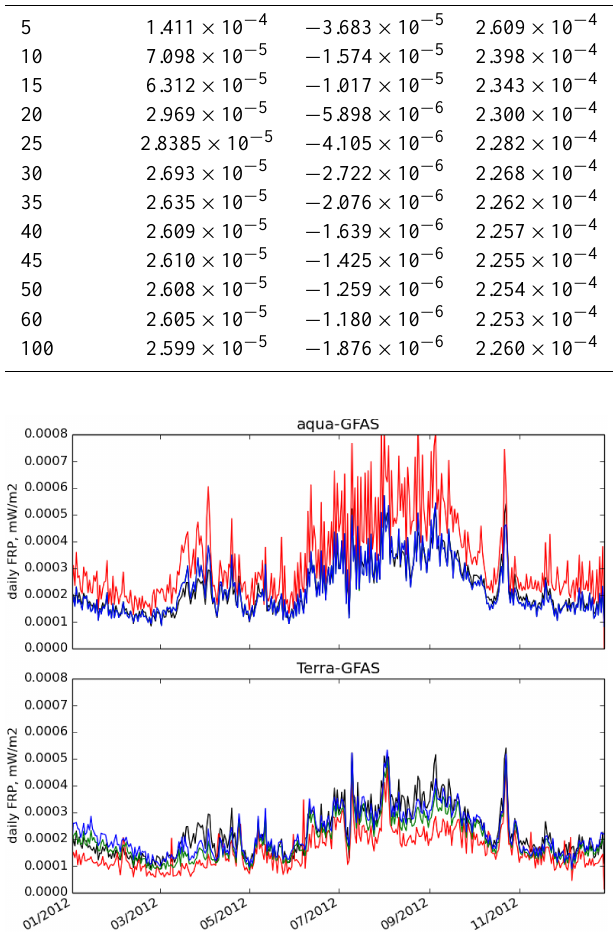
Figure 7. Daily global FRP from Aqua- and Terra-GFAS (in red) (Aqua, top; Terra, bottom) and from Full-GFAS (in black). The lin- ear regression applied to Aqua- and Terra-GFAS is shown in green, while the mix of linear and non-linear approaches is displayed in blue. Data from 01/01/2012 to